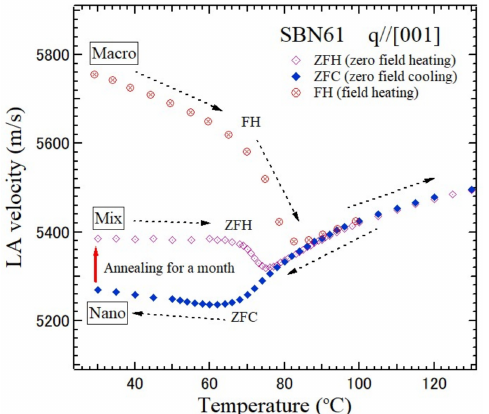
Figure 12. Variation of the LA velocity of SBN61 in the “Nano” state during ZFC without poling, the “Mix” state during zero field heating (ZFH) after a month at room temperature, and the “Macro” state during FH [70].